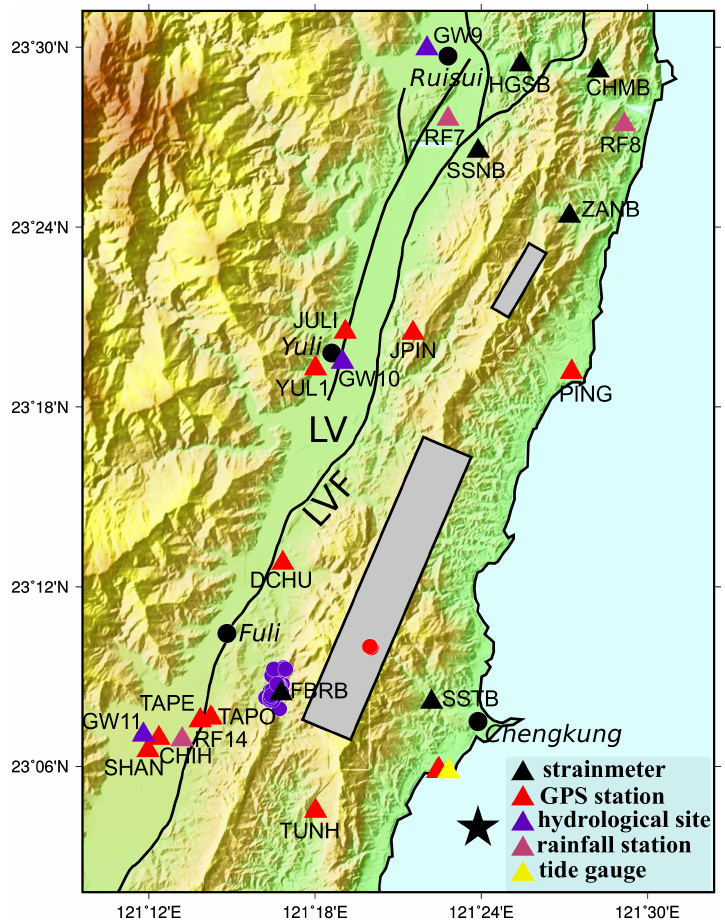
Figure 11. Major faults and instrumentation in eastern Taiwan. Large and small gray rectangles denotes the surface projection of the 2011 and 2013 SSE source faults, respectively. Red and blue dots represent the relocated earthquake multiplet and aftershocks that coincide with the 2011 SSE and 2010 afterslip, respectively. Black star denotes the Chengkung earthquake epicenter and black dots the main